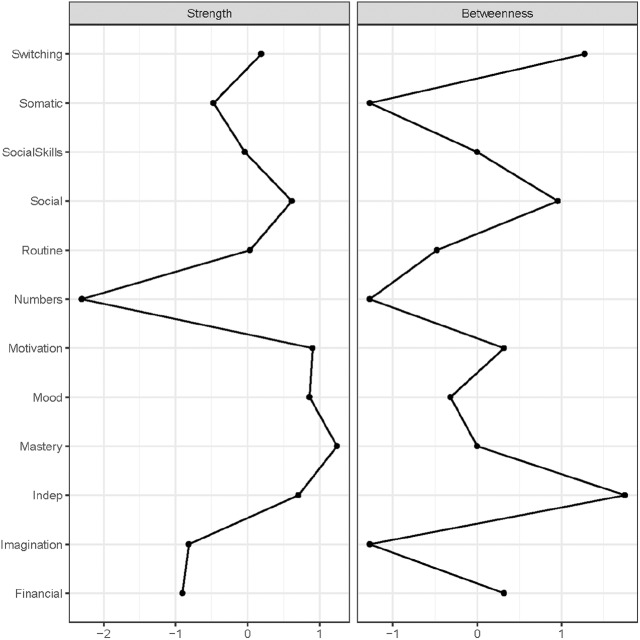
Standardized (i.e. z-scores) centrality indices node strength and betweenness for the depression cohort network in Figure 1.